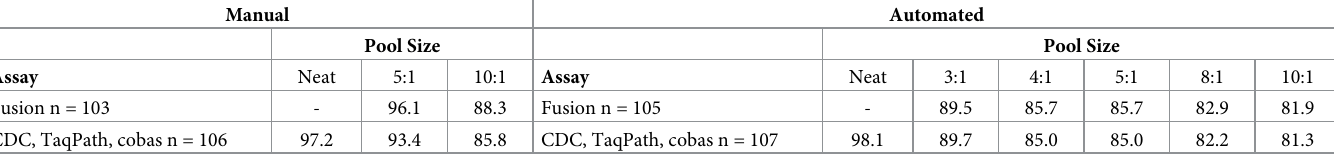
Fusion n = 103 CDC, TaqPath, cobas n = 106